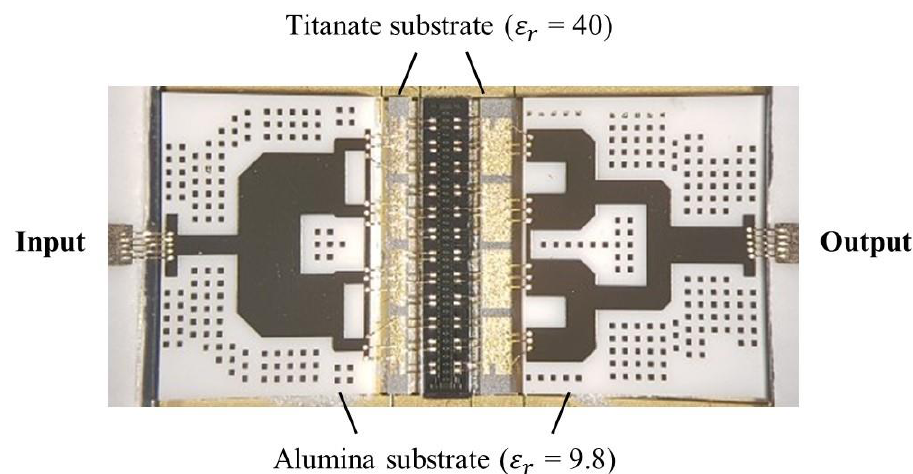
Figure 7. Fabricated internally-matched power amplifier using a GaN bare die and 4 input and output matching substrates.